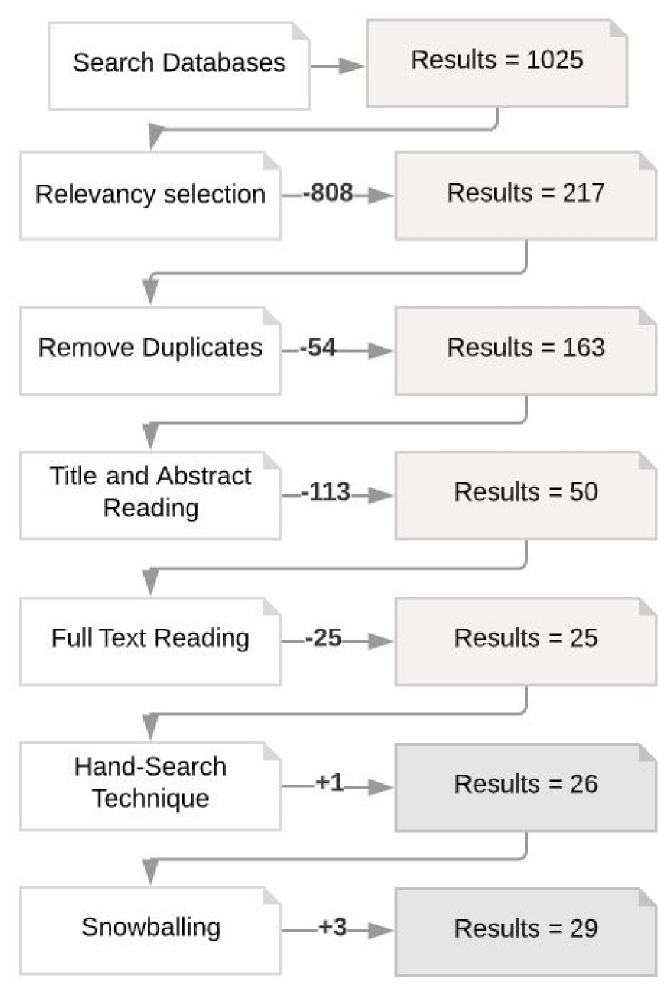
Fig 1. Number of papers in each sub-step of selection